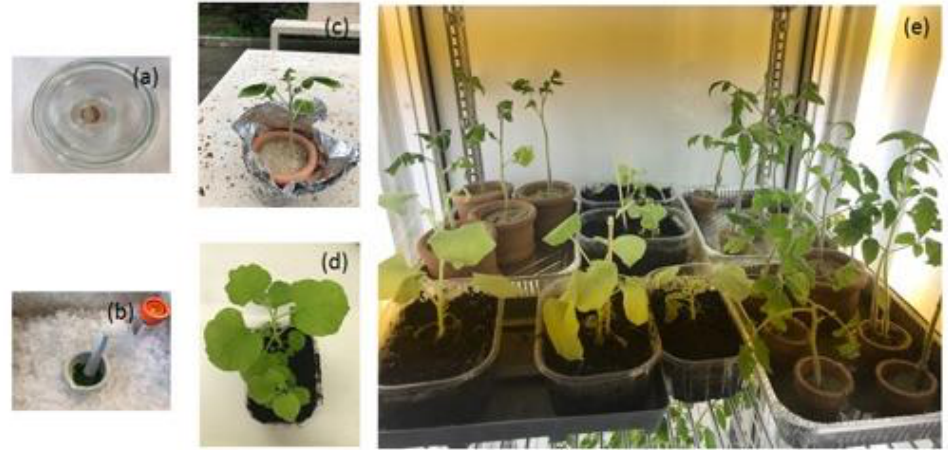
Figure 1. Inoculum of J2 ( a ) and CymRSV virus ( b ), a tomato plant ( c ), a tobacco plant ( d ), and healthy and infected plants in the growth chamber ( e ).